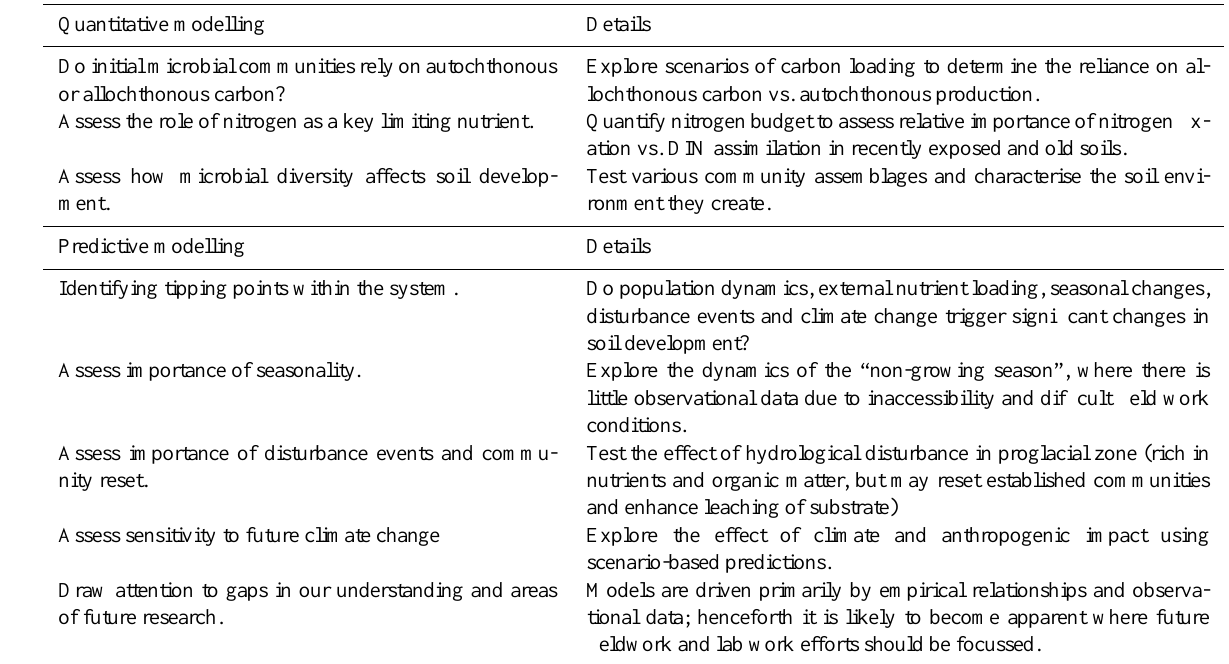
Figure 1. A conceptual overview of the main transformations and fluxes of nutrients and organic matter in and along a typical de-glaciated forefield. Table 1. Outline of quantitative and predictive modelling